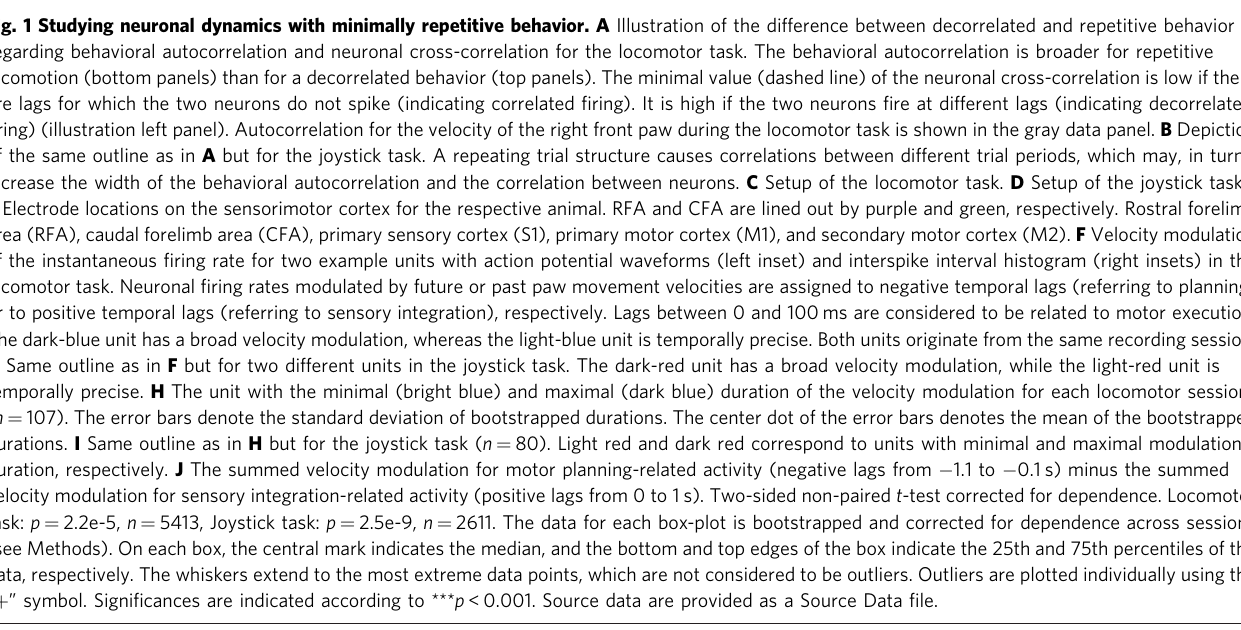
Fig. 1 Studying neuronal dynamics with minimally repetitive behavior. A Illustration of the difference between decorrelated and repetitive behavior regarding behavioral autocorrelation and neuronal cross-correlation for the locomotor task. The behavioral autocorrelation is broader for repetitive locomotion (bottom panels) than for a decorrelated behavior (top panels). The minimal value (dashed line) of the neuronal cross-correlation is low if there are lags for which the two neurons do not spike (indicating correlated fi ring). It is high if the two neurons fi re at different lags (indicating decorrelated fi ring) (illustration left panel). Autocorrelation for the velocity of the right front paw during the locomotor task is shown in the gray data panel. B Depiction of the same outline as in A but for the joystick task. A repeating trial structure causes correlations between different trial periods, which may, in turn, increase the width of the behavioral autocorrelation and the correlation between neurons. C Setup of the locomotor task. D Setup of the joystick task. E Electrode locations on the sensorimotor cortex for the respective animal. RFA and CFA are lined out by purple and green, respectively. Rostral forelimb area (RFA), caudal forelimb area (CFA), primary sensory cortex (S1), primary motor cortex (M1), and secondary motor cortex (M2). F Velocity modulation of the instantaneous fi ring rate for two example units with action potential waveforms (left inset) and interspike interval histogram (right insets) in the locomotor task. Neuronal fi ring rates modulated by future or past paw movement velocities are assigned to negative temporal lags (referring to planning) or to positive temporal lags (referring to sensory integration), respectively. Lags between 0 and 100 ms are considered to be related to motor execution. The dark-blue unit has a broad velocity modulation, whereas the light-blue unit is temporally precise. Both units originate from the same recording session. G Same outline as in F but for two different units in the joystick task. The dark-red unit has a broad velocity modulation, while the light-red unit is temporally precise. H The unit with the minimal (bright blue) and maximal (dark blue) duration of the velocity modulation for each locomotor session ( n = 107). The error bars denote the standard deviation of bootstrapped durations. The center dot of the error bars denotes the mean of the bootstrapped durations. I Same outline as in H but for the joystick task ( n = 80). Light red and dark red correspond to units with minimal and maximal modulation duration, respectively. J The summed velocity modulation for motor planning-related activity (negative lags from − 1.1 to − 0.1 s) minus the summed velocity modulation for sensory integration-related activity (positive lags from 0 to 1 s). Two-sided non-paired t -test corrected for dependence. Locomotor task: p = 2.2e-5, n = 5413, Joystick task: p = 2.5e-9, n = 2611. The data for each box-plot is bootstrapped and corrected for dependence across sessions (see Methods). On each box, the central mark indicates the median, and the bottom and top edges of the box indicate the 25th and 75th percentiles of the data, respectively. The whiskers extend to the most extreme data points, which are not considered to be outliers. Outliers are plotted individually using the “ + ” symbol. Signi fi cances are indicated according to *** p < 0.001. Source data are provided as a Source Data fi